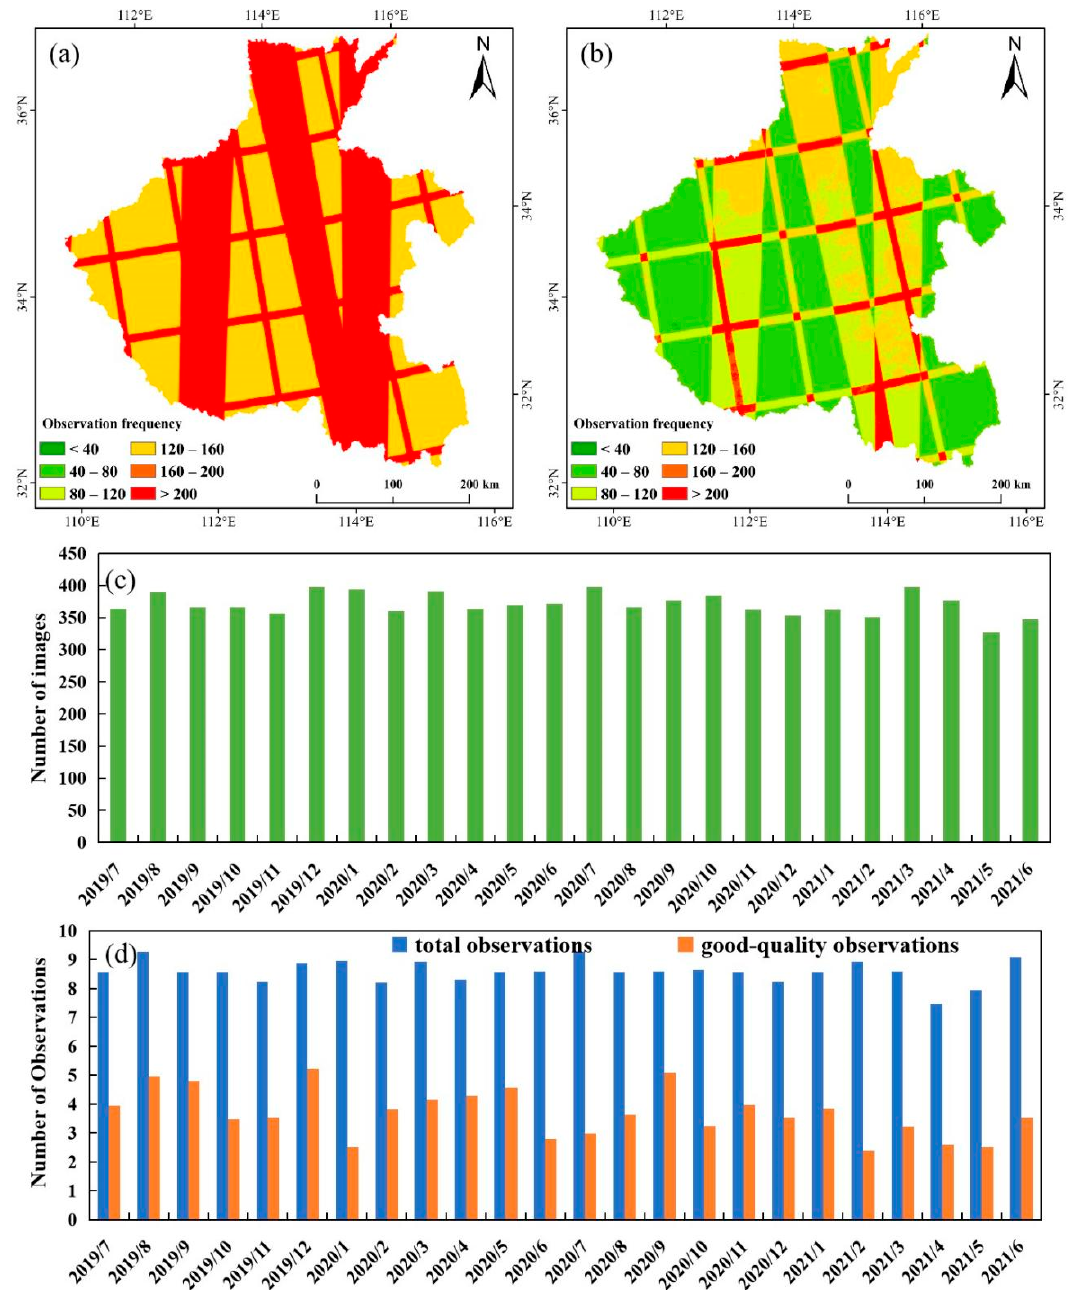
Figure 2. ( a , b ) Numbers of total observations and good-quality observations for individual pixels during the study period, respectively. ( c ) Number of Sentinel-2A/B images per month during 1 July 2019–1 July 2021. ( d ) Average number of total and good-quality observations per pixel during 1 July 2019–1 July 2021.